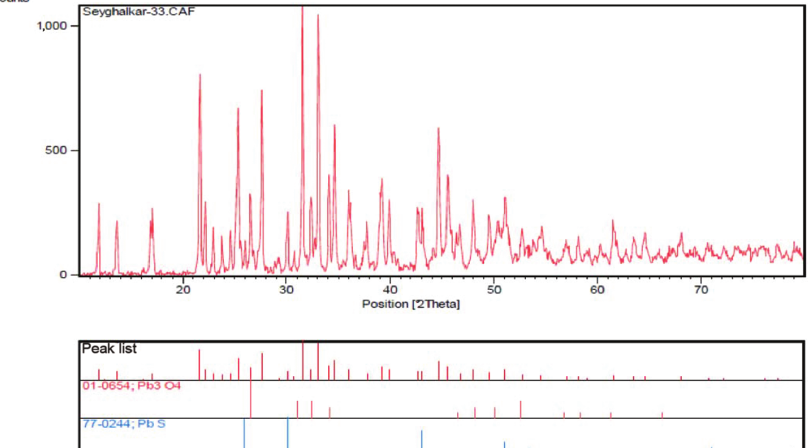
Figure 4: XRD pattern of sample no.